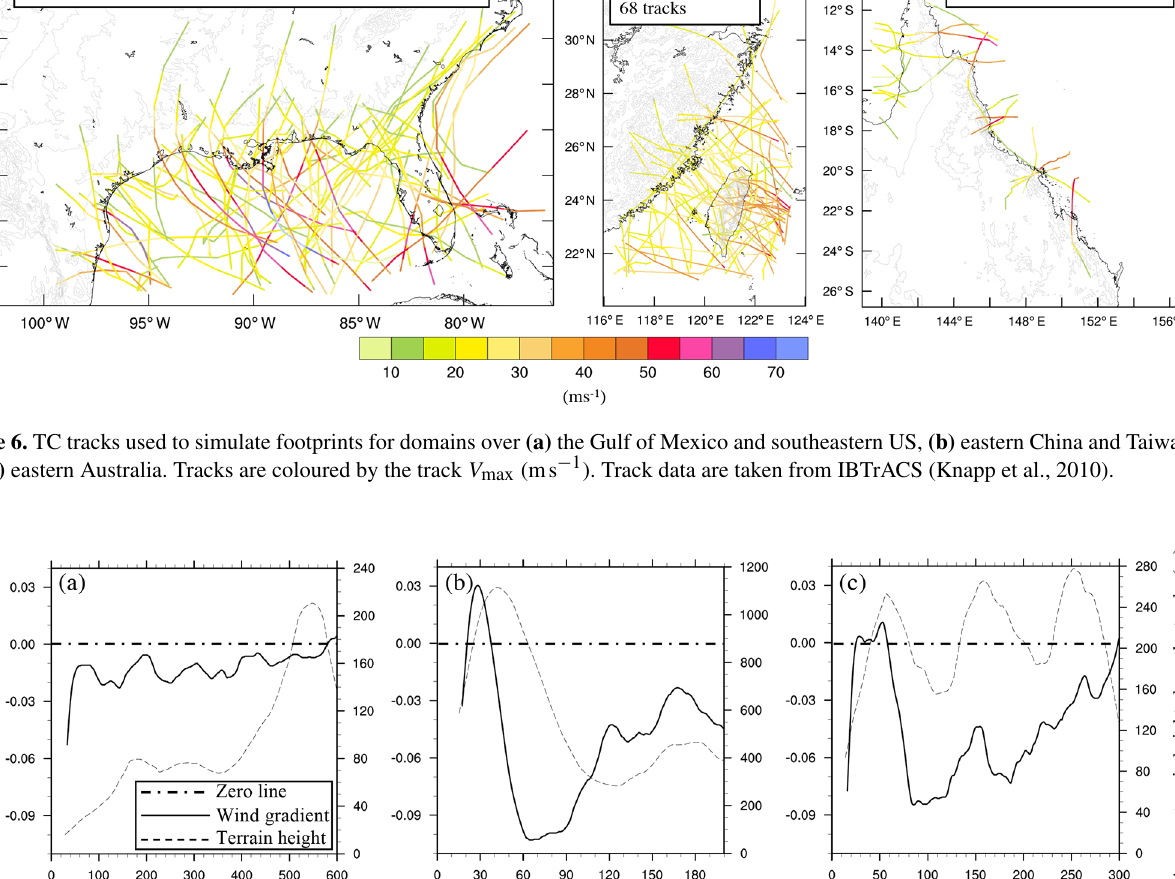
are additionally smoothed using a 30 km running